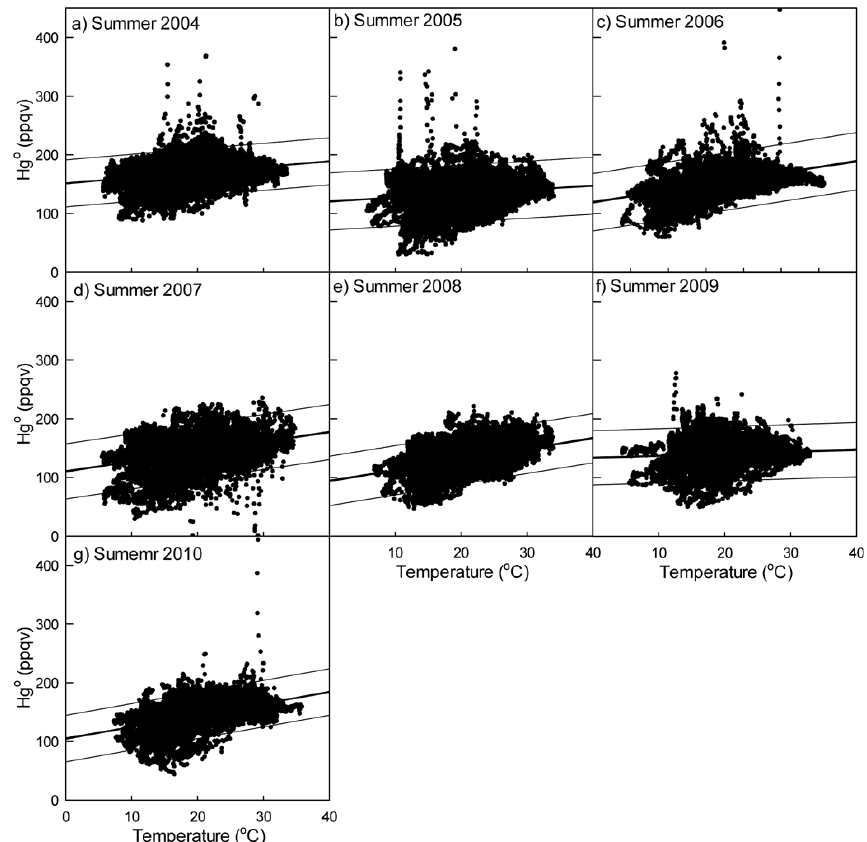
Fig. 7. Mixing ratios of Hg 0 versus temperature in summers of 2004–2010 at TF